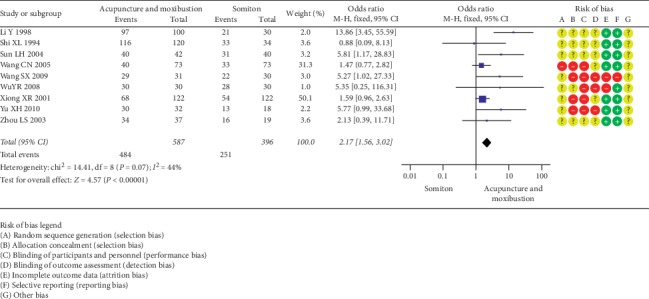
Acupuncture and moxibustion vs. Somiton.